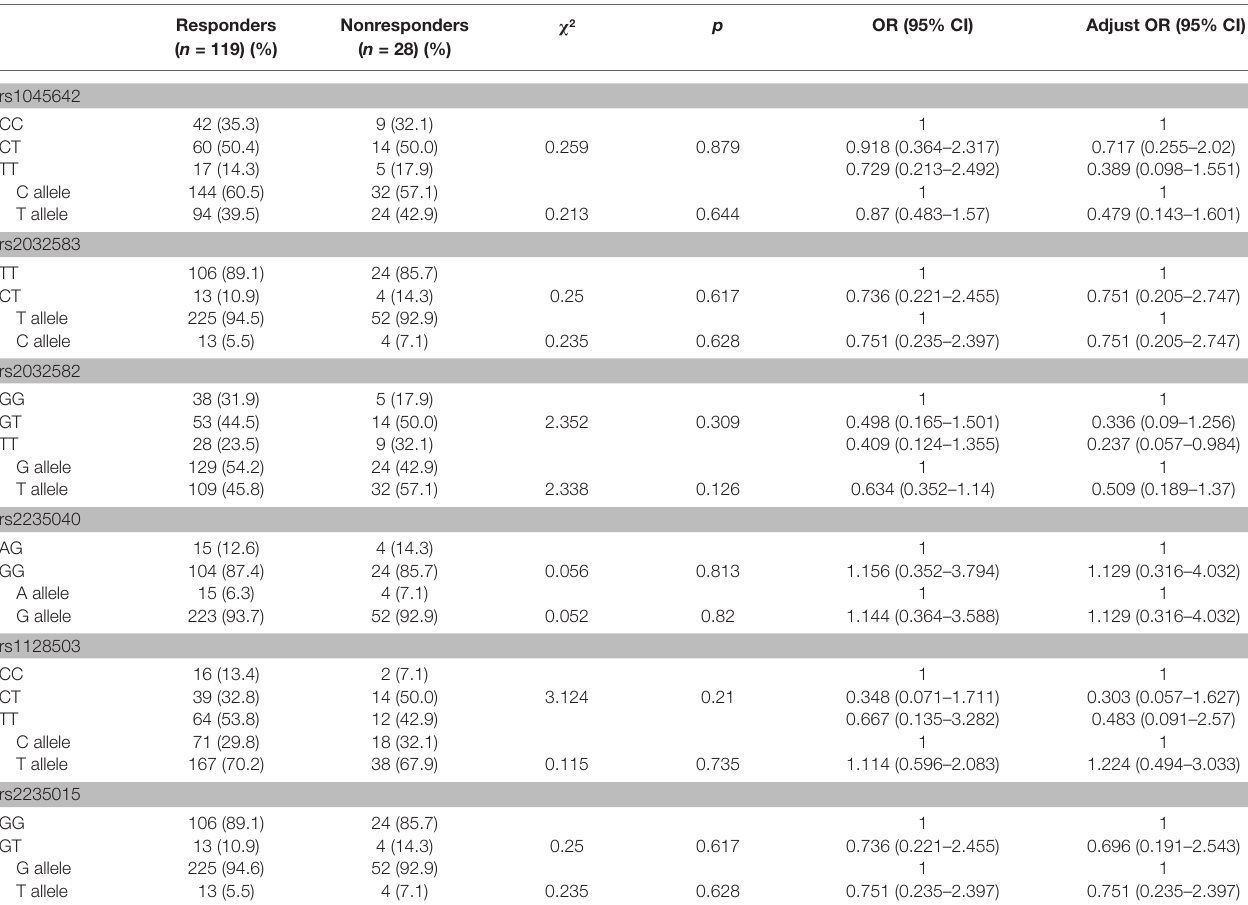
TABLE 4 | Genotype, allelic distribution of all genotyped single nucleotide polymorphisms among the treatment responders and nonresponders for selective serotonin reuptake inhibitor (SSRI) drugs group. Responders ( n = 119) (%)